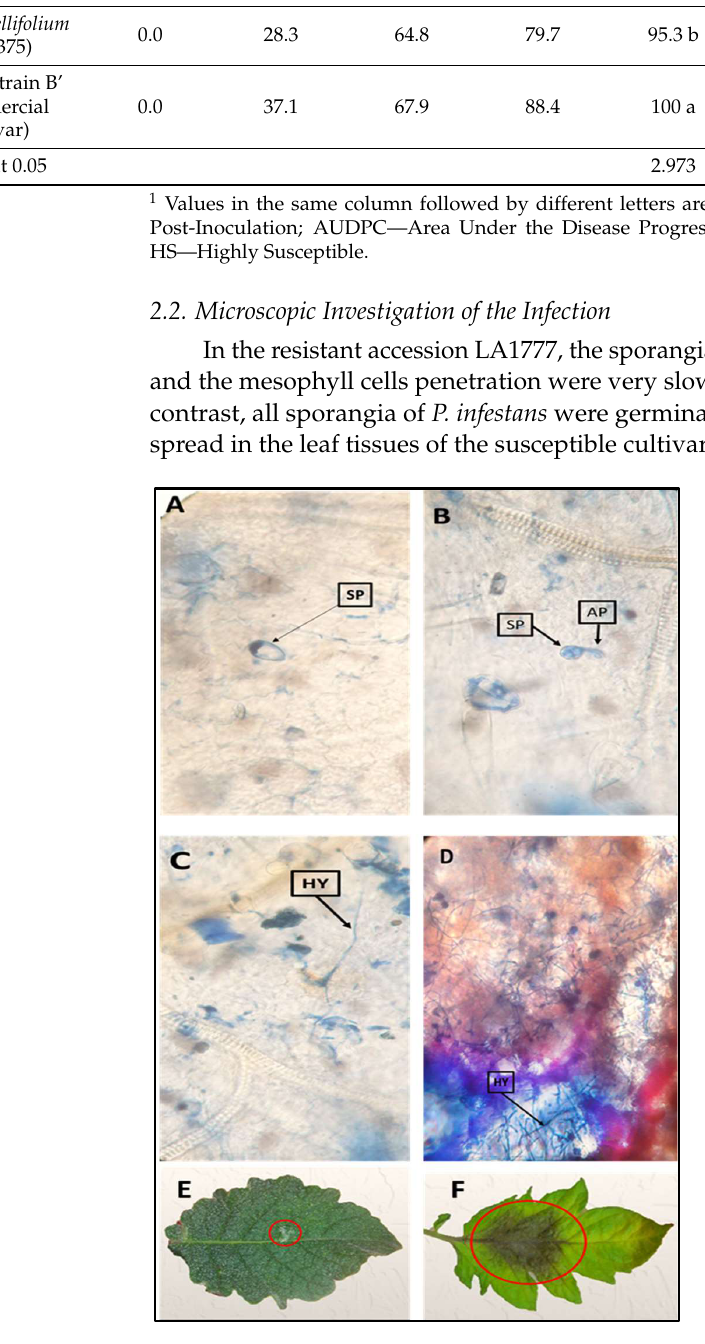
Figure 1. Observations of sporangia germination progression of Phytophthora infestans on tomato wild relative leaves under a light microscope at 72 h after inoculation (HAI) ( A – D ): ( A ) no germi- nation of sporangium; ( B , C ) very slow germination of sporangia, appresorium formation and weak penetration on S. habrochaites accession LA1777 leaves as a resistant wild type to late blight; ( D ) colonization of intense mycelium inside host cells and penetration of the leaf tissue on the suscepti- ble tomato cultivar Castlerock. Evaluation of resistance and lesion progression of late blight on to- mato leaflets of two germplasm at 96 HAI in vitro; ( E ) LA1777; ( F ) Castlerock cultivar. Sp—Sporan- gium; Ap—Appressorium; Hy—Hypha. 2.3. Metabolic Profiling in Late Blight Resistant and Susceptible Tomato Genotypes Our data showed that 31 volatile organic compounds (VOCs) were detected in the five tomato genotypes (Table 3). In the control group (non-inoculated plants), the number of VOCs ranged from 16 to 21 in the three resistant genotypes (LA1352, LA2855, and LA1777), while the numbers were 13 and 14 in the two susceptible genotypes (‘Super Strain B’ and S. pimpinellifolium LA0375), respectively. In the inoculated group, the num- ber of VOCs ranged from 11 to 22 in the resistant genotypes while it was 14 and 15 in the susceptible genotypes ( S. pimpinellifolium LA0375 and ‘Super Strain B’), respectively. Table 3. Volatile organic compounds identified in the leaf extract of tomato genotypes using GC/MS and where RT—Retention Time, MF—Molecular Formula, and MW—Molecular Weight (in g/mol). Name